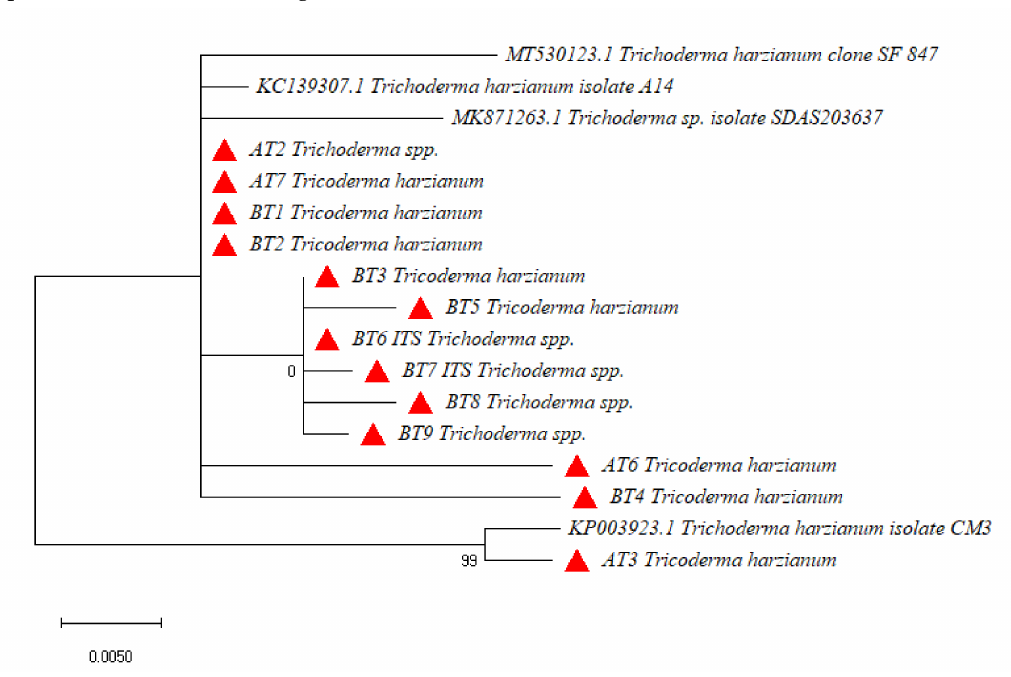
Figure 1. Phylogenetic relationship of Trichoderma spp using the internal transcribed spacer (ITS) region gene nucleotide sequence alignment using maximum likelihood method at 1000 replications for each bootstrap value using the MEGA 10.0, symbols in red triangles phylogeny represents our